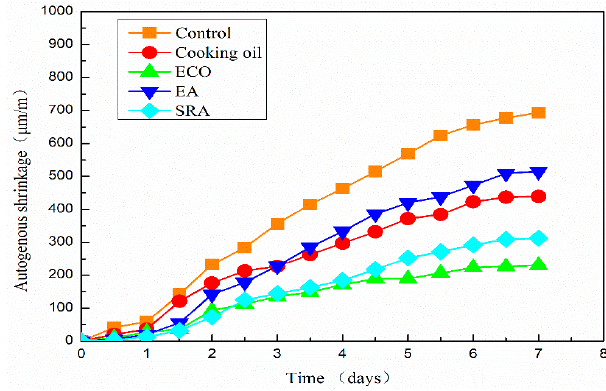
Figure 6. Autogenous shrinkage of AASC with various of agents.